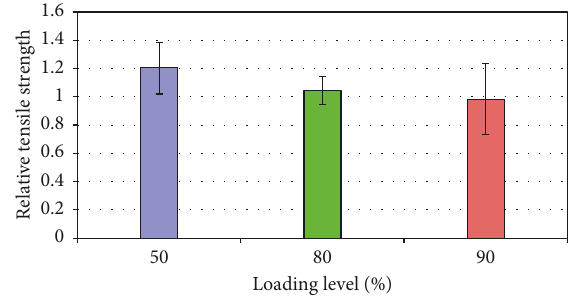
Figure 16: Tensile strength of creep-loaded specimens (relative to the average of the unloaded specimens) vs. the creep loading level. The error bar represents the maximum and minimum relative strength values (for 3 specimens). The variabilities of 3 accom- panying control specimens ranged between ± 0.02 for a 50% loading level; +0.20 and − 0.16 for an 80% loading level; and +0.12 and − 0.09 for a 90%